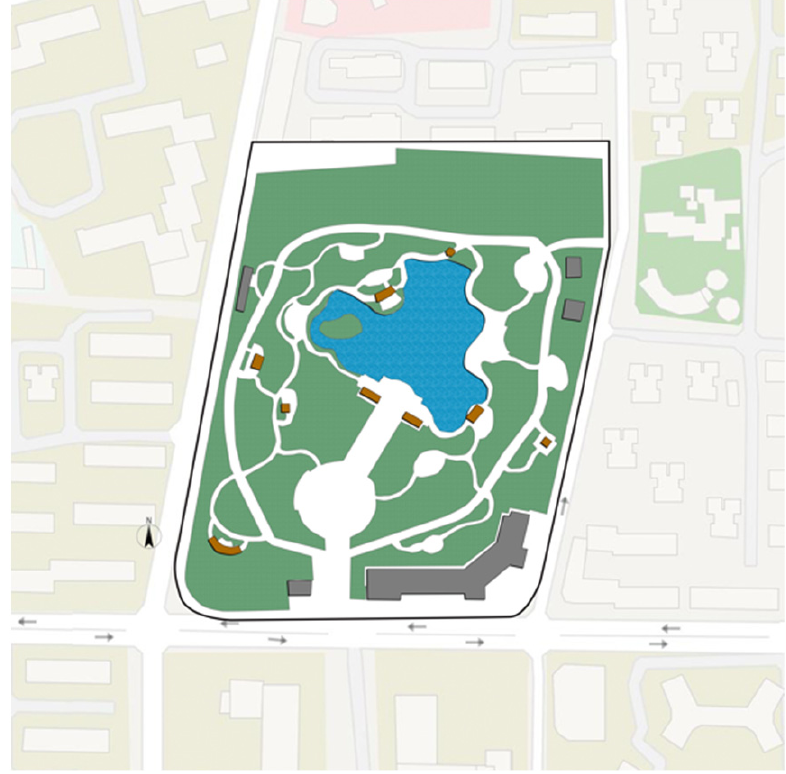
Figure 4. Map of Lingnan Park.